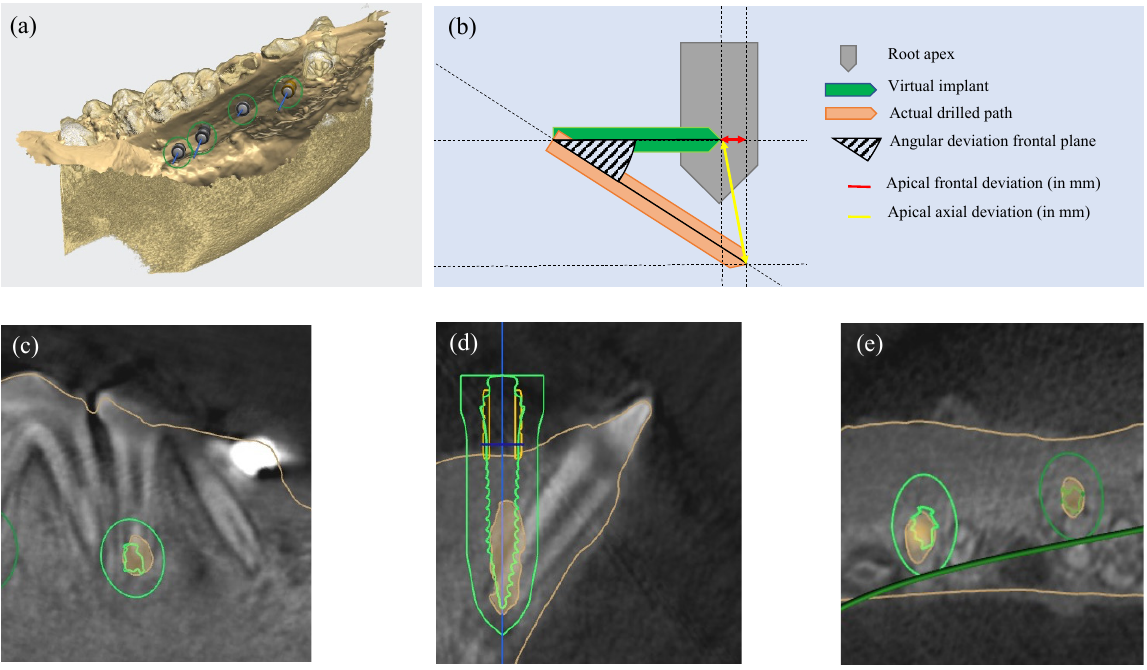
Figure 4. Determination of the measurement deviation calculation and angular deviation at the level of the apex. ( a ) The preoperative 3D reconstruction of the pig jaw shows the virtual implants in direction of the targeted root apices. ( b ) The illustration shows the calculation of the apical deviation of the tip of the virtual implant in comparison with the actual drilled path. ( c ) Sagittal view, ( d ) coronal view, and ( e ) axial view of the superposition between the virtual planned implant (green) and the actual drill path (orange).The green circle represents the implant’s safety zone. The blue line shows the main axis of the implant. The dark green line represents the panoramic curve.